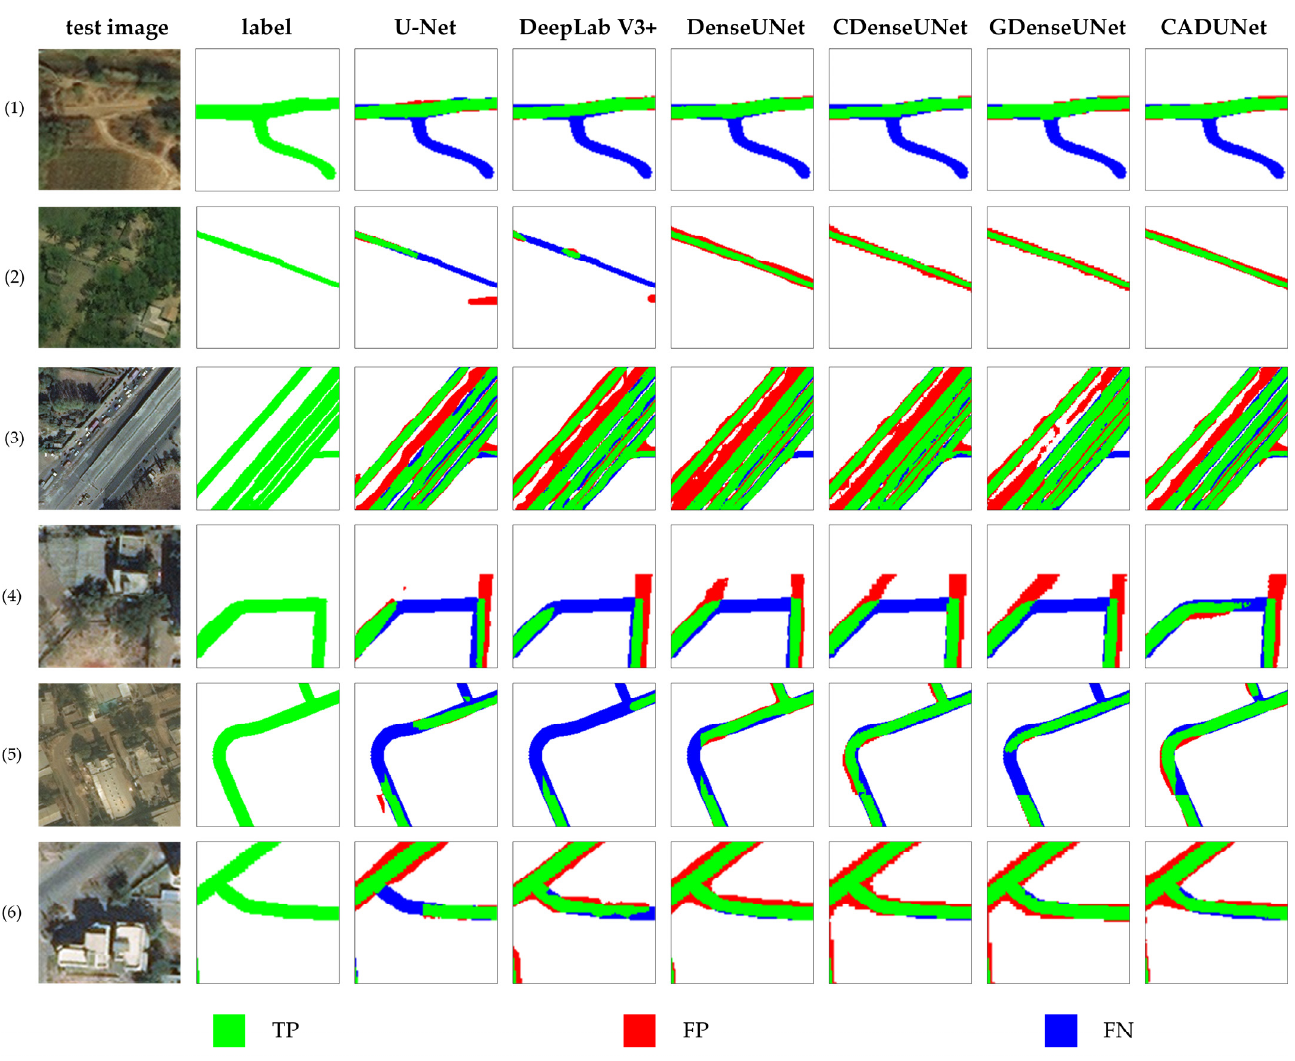
Figure 12. Visual accuracy assessment of road extraction based on the CVPR dataset. ( 1,2 ) The rural roads; ( 3 ) The parallel roads; ( 4 ) Intersection roads; ( 5,6 ) The urban road occluded by the shadow of the buildings.